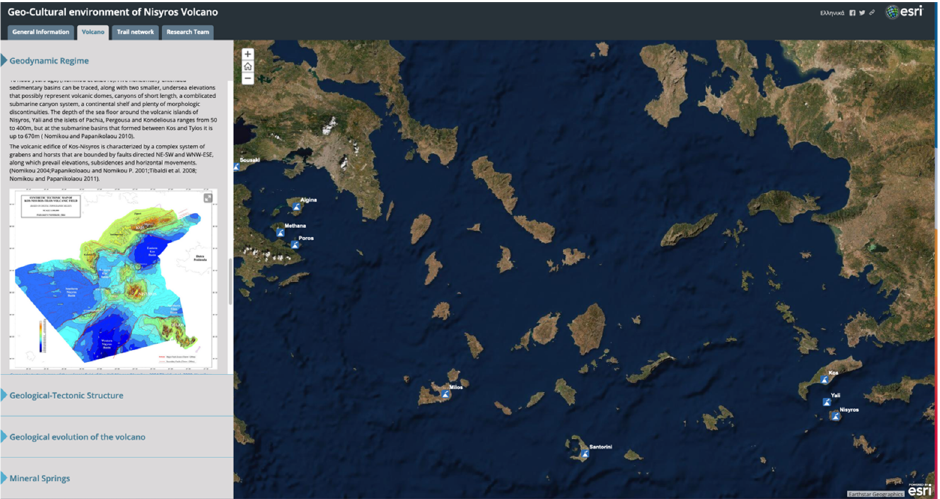
Figure 11 . Screenshot showing part of the narration about the geodynamic regime of the island accompanied by the webmap featuring the location of all volcanic islands across the Hellenic Volcanic Arc.